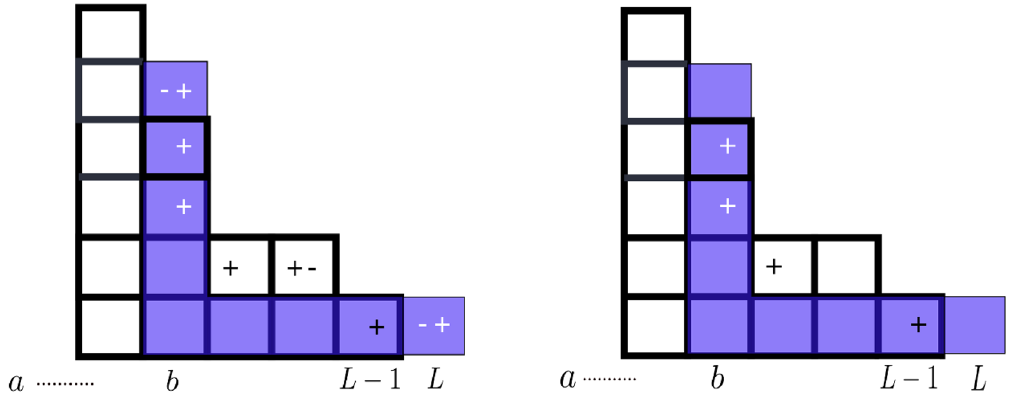
Figure 4 . Example of Young tableaux Y a;(cid:13) and Y b;(cid:14)